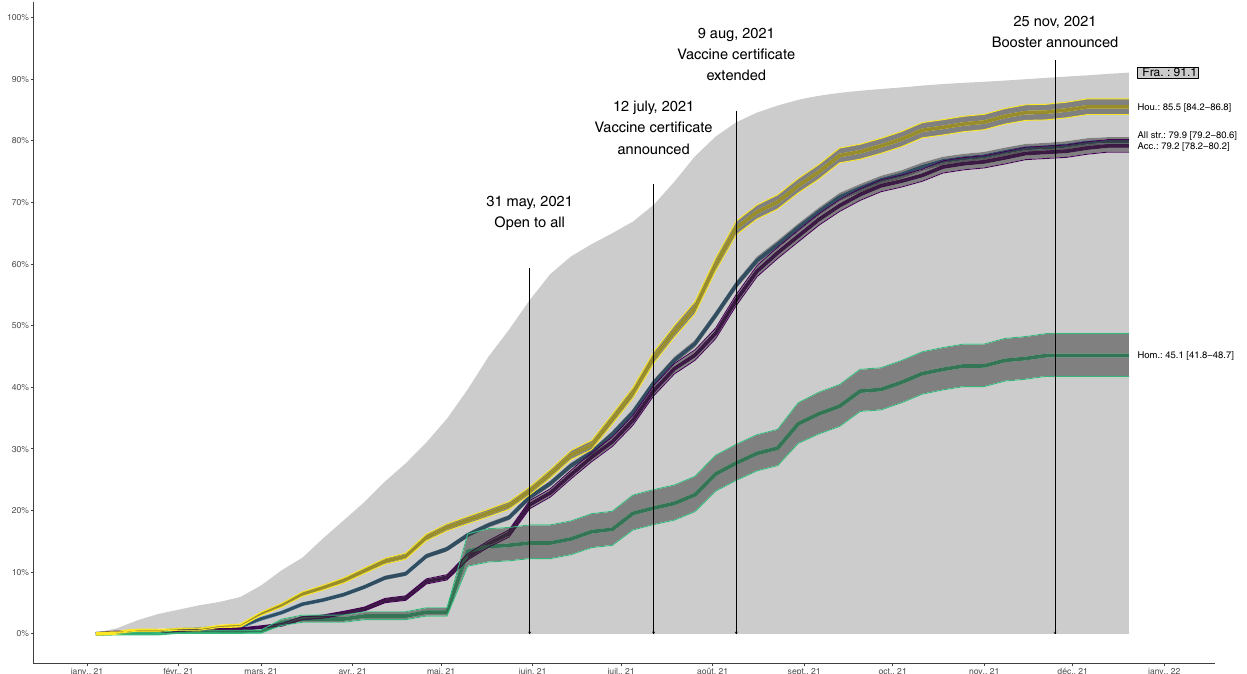
Fig. 2 Standardized vaccination rates: strata vs French general population. Yellow line is the standardized vaccine uptake for the Precariously Housed stratum (with corresponding 95% CIs yellow band), the purple line is the standardized vaccine uptake for Accommodated stratum and the green line is the standardized vaccine uptake for the Streets stratum. Dark blue line is the standardized vaccine uptake for all strata combined and the grey area is the standardized vaccine uptake for all French adults above 18. Sample sizes are as follows: n = 3690 for the Total sample representing a total standardized population of 100,567, n = 855 for Precariously Housed representing a standardized population of 22,788, n = 1321 for Accommodated representing a standardized population of 73,159 and n = 514 for Streets representing a standardized population of 4620. Population size for French adults above 18 was 52,751,109 as of December 28, 2021. Source data for this fi gure are available in Supplementary Data 10. A reproducibility guide for fi gures and tables is available in Supplementary Methods